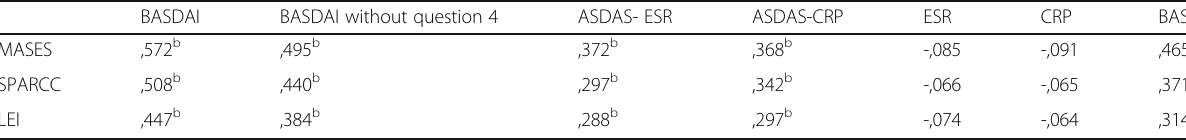
Table 2 Correlation of the enthesitis indices with disease activity and function in 145 patients fulfilling ASAS criteria for axial SpA BASDAI BASDAI without question 4 ASDAS- ESR ASDAS-CRP